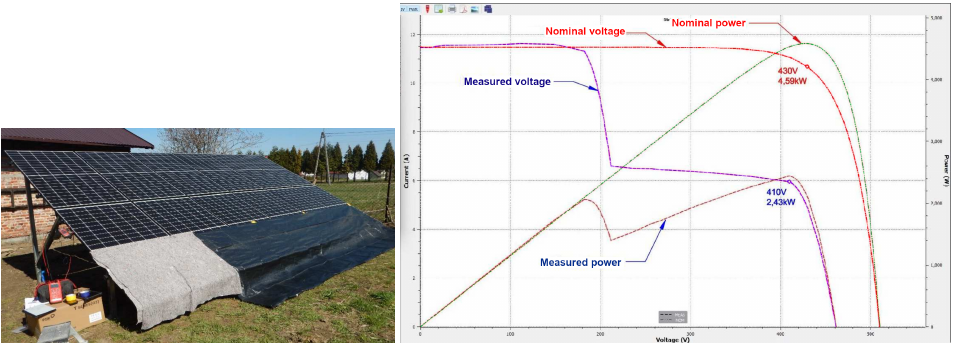
Figure 9. Impact of covering of the installation’s lower part on the string’s